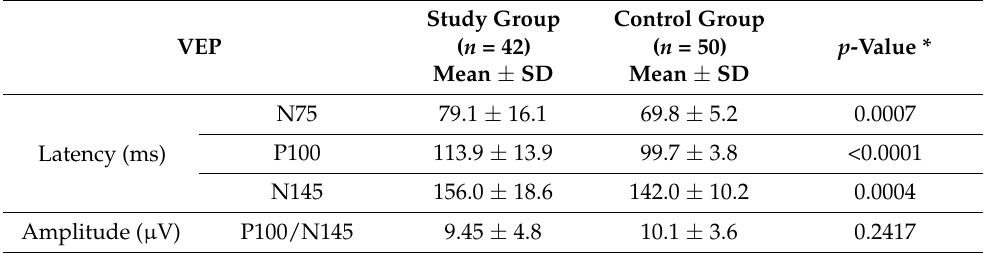
Table 1. VEP parameters in myasthenia gravis patients and in the control group.